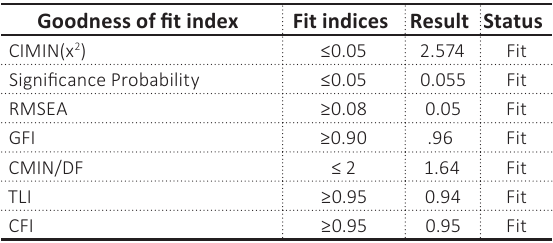
Table 1. The goodness of fit indices Goodness of fit index